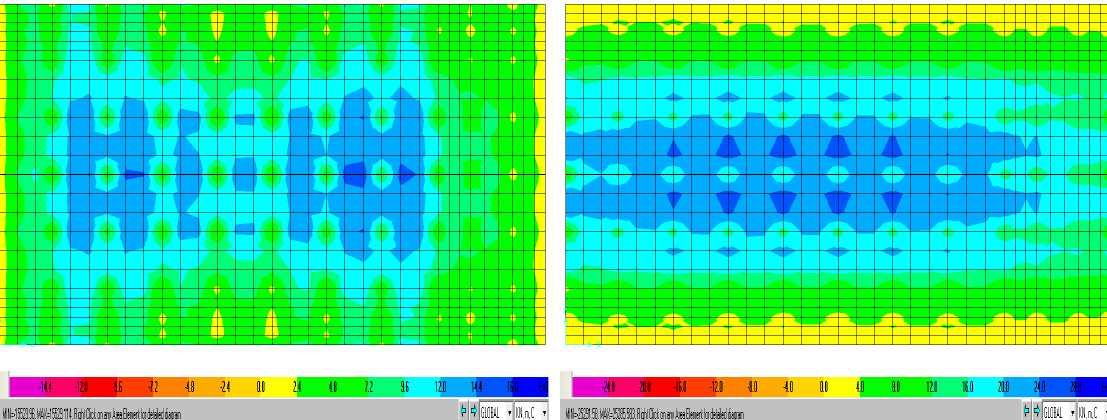
Figure 10. Stress contours in the RC plate assuming a fixed and hinged connection with piles.